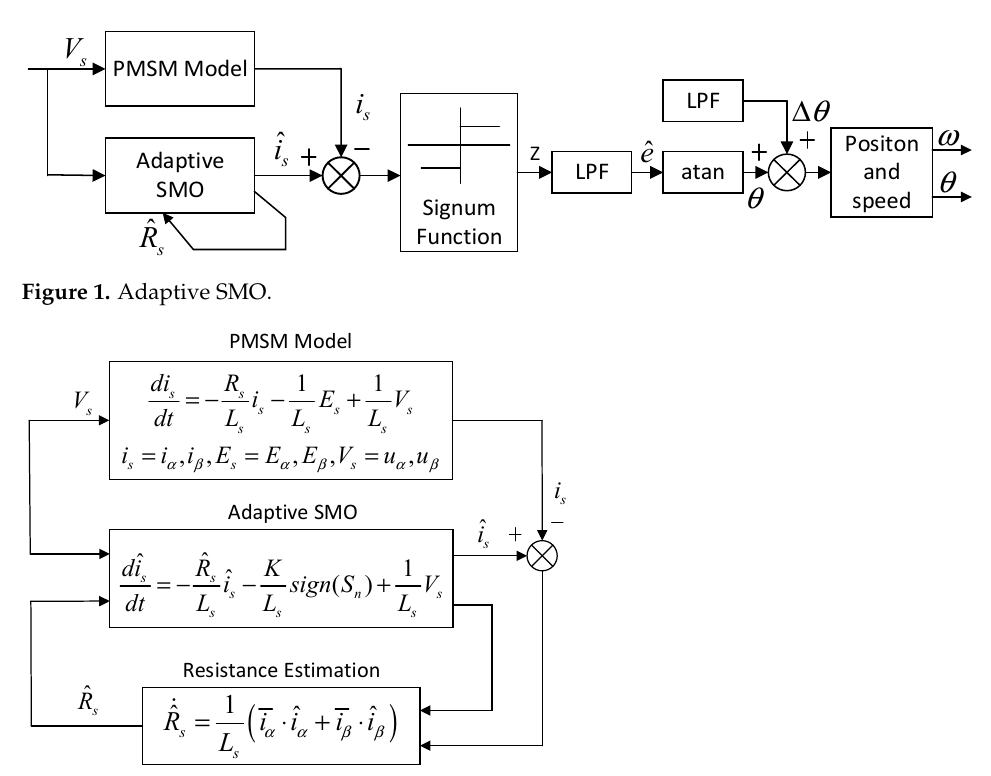
Figure 2. Online resistance parameter identification.